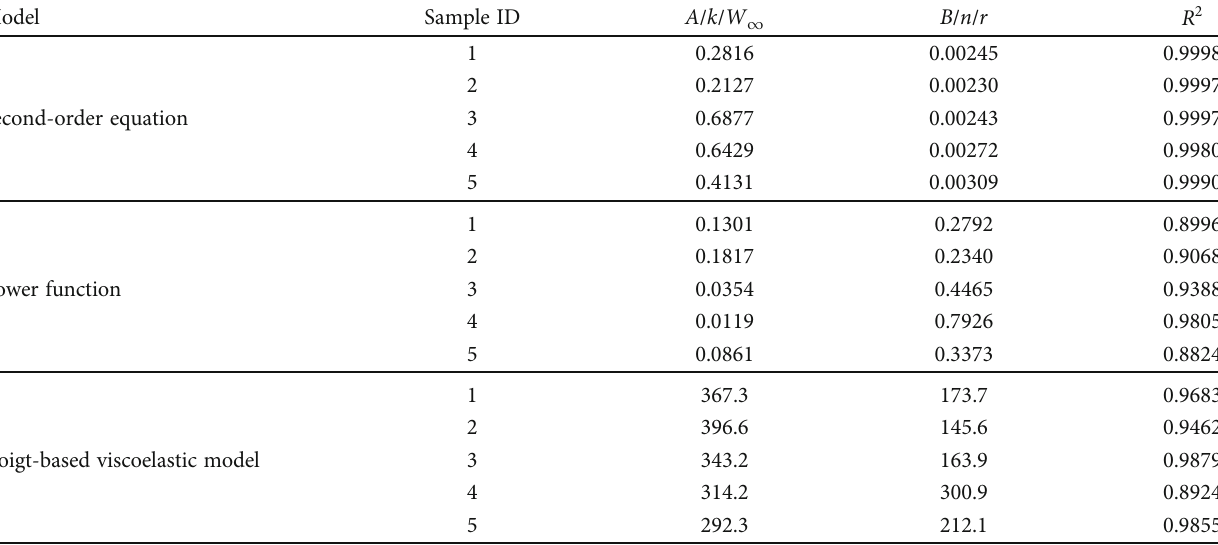
Table 2: Results of the model fi tting.